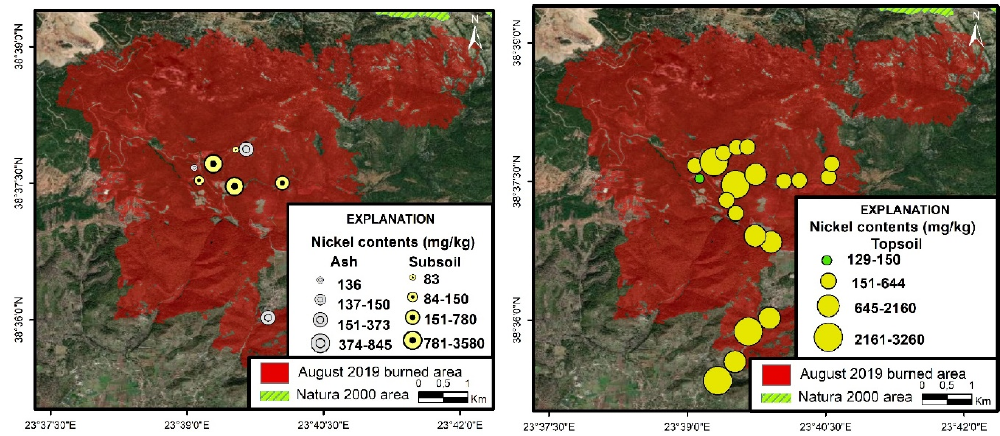
Figure 7. Map showing nickel contents in ash, topsoil and subsoil at the study area (modified from [23,24,26]). Figure 7.